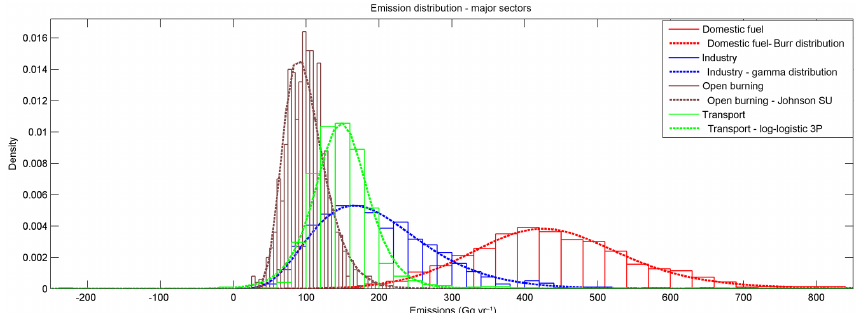
Figure 10. Sectorial emission histograms and associated best-fit